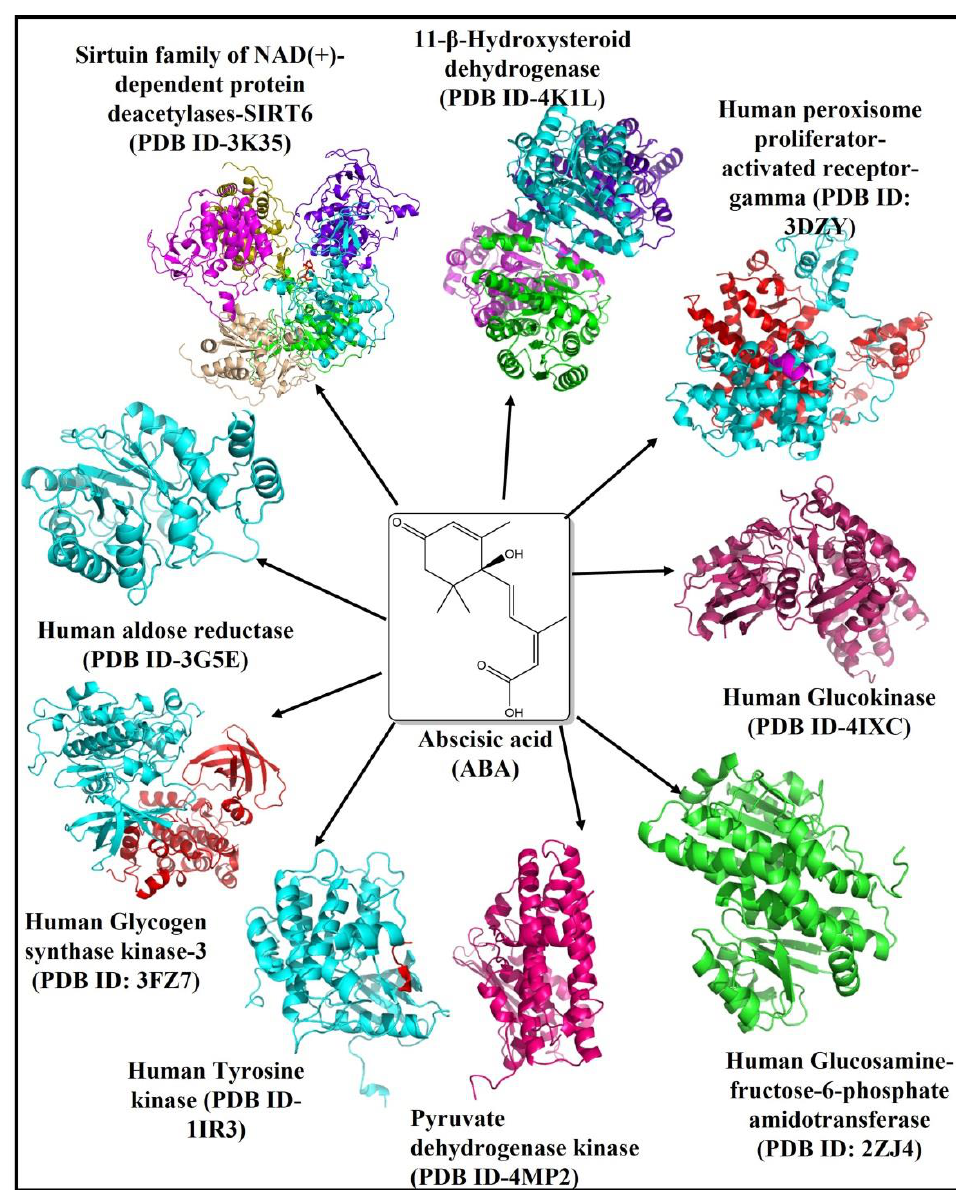
Figure 1. The chemical structure of ABA (center). The human proteins involved in the development of diabetes are 11 β -Hydroxysteroid dehydrogenase [11 β -HSD (PDB ID-4K1L)], aldose reductase (PDB ID-3G5E), glucokinase (PDB ID-4IXC), glycogen synthase kinase-3 (PDB ID-3F7Z), glucosamine-fructose-6-phosphate amidotransferase [GFAT (PDB ID-2ZJ4)], pyruvate dehydrogenase kinase (PDB ID-4MP2), peroxisome proliferator-activated receptor-gamma (PDB ID-3DZY), Sirtuin family of NAD(+)-dependent protein deacetylases [SIRT6 (PDB ID-3K35)] and Tyrosine kinase (PDB ID-1IR3), were individually docked with ABA.